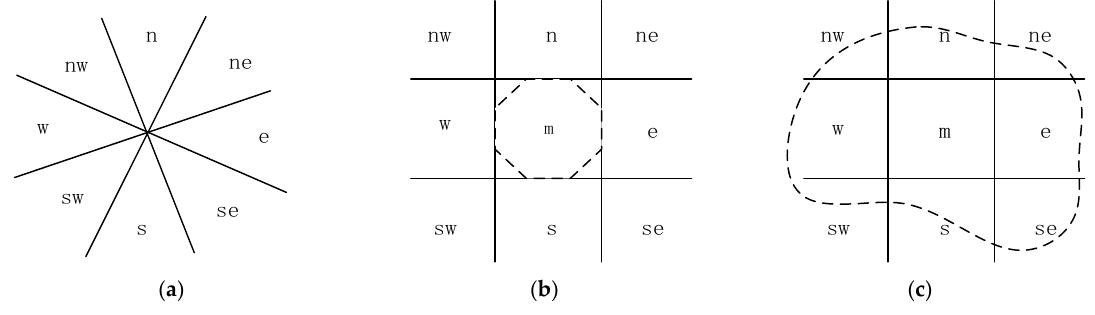
Figure 3. ( a ) Cone-based CDR model; ( b ) MBR-based CDR model; ( c ) MBR-based ICD model (the dashed line is the reference object, and the solid lines are the boundaries of directions).